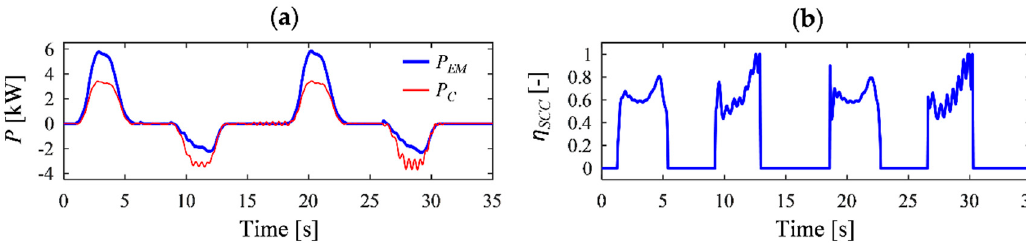
Figure 13. ( a ) Measured input power and simulated output power of the self-contained cylinder; ( b ) Measured and simulated overall energy efficiency of the self-contained cylinder.